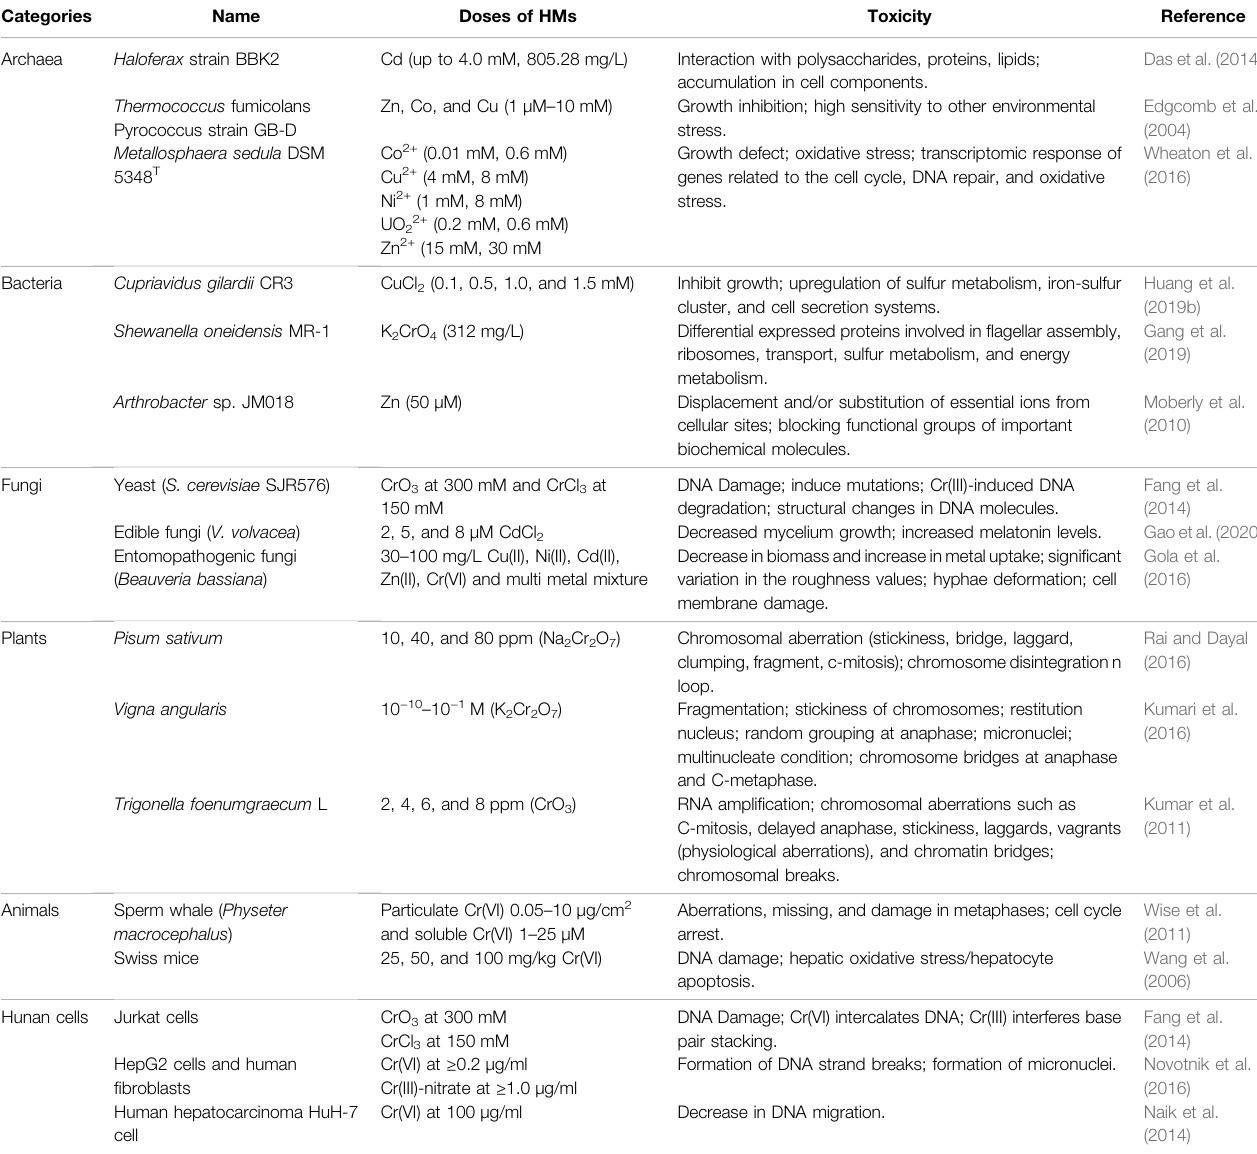
TABLE 4 | HM-induced toxicity in different biological